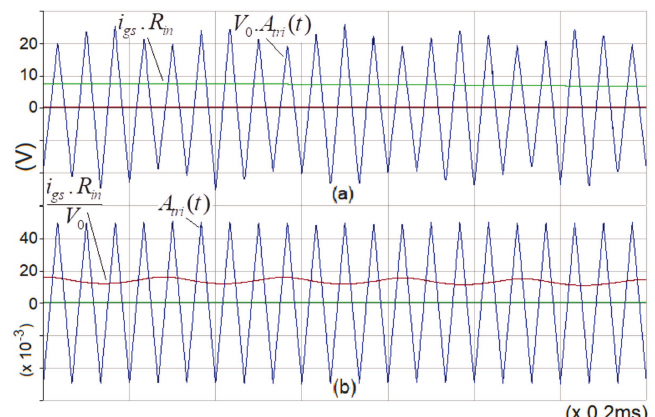
Figure 4. Software-OCC waveforms to f C = 15 kHz and f = 60 Hz, it was considered V 0 = 450 + 67.5 sin ( 2 π f 2 t ) V , where f 2 = 3.6 kHz and R in = 1 Ω . ( a ) Classical modulator Equation (23). ( b ) Modified modulator Equation